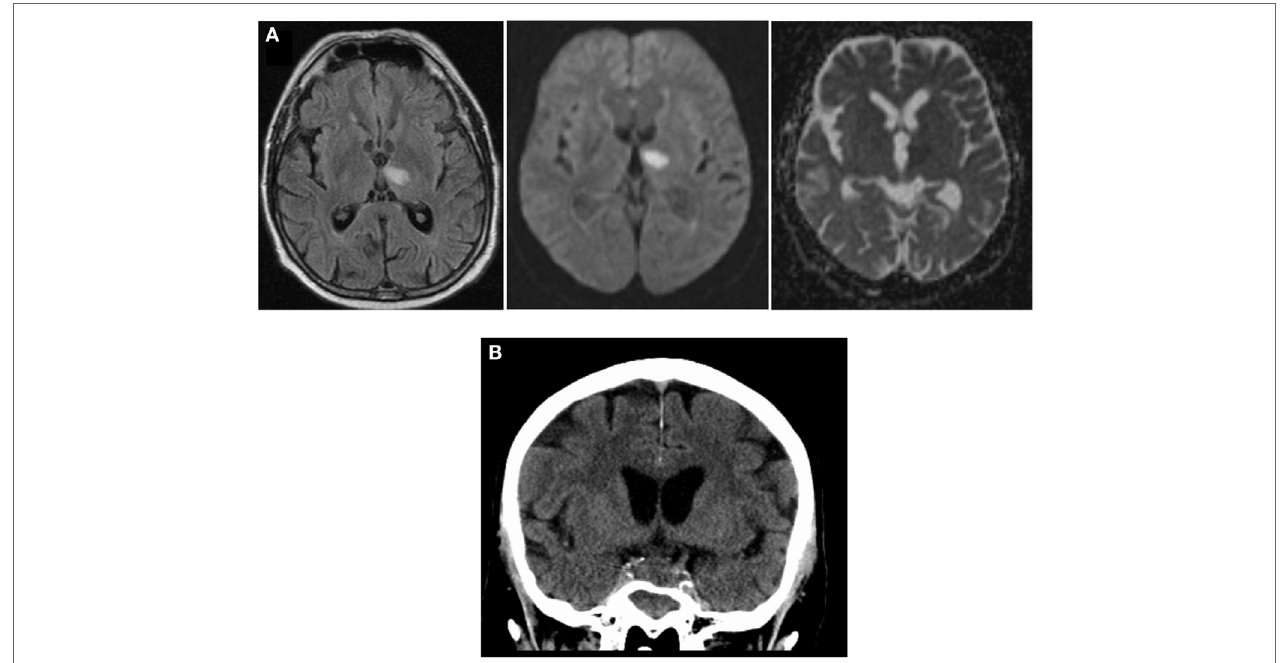
FIGURe 1 | Imaging during course of disease: (a) NMR imaging on day 3 after admission shows hyperintensity in FLAIR sequence (left), high degree of diffusion-positivity (DWI, middle), and lack of shine-through effect in ADC (right), indicating acute thalamic infarction. (B) cCT scan (day 10) showing increased sellar